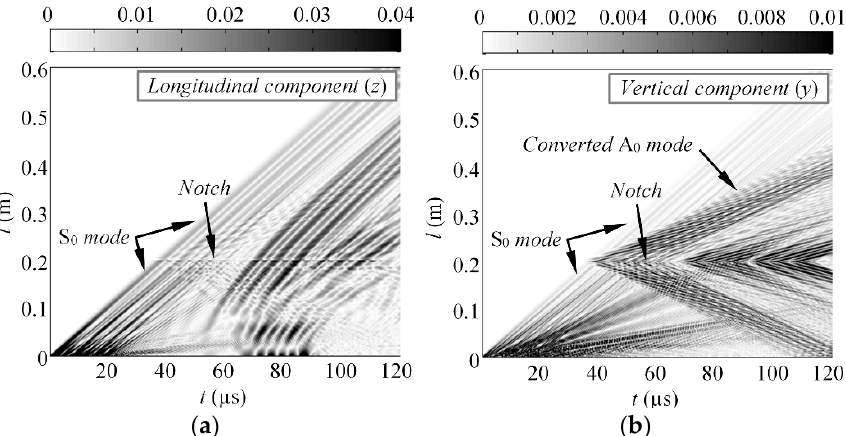
Figure 8. The ( a ) longitudinal and ( b ) vertical component of particle velocity along the centreline of the sample, in case of 150 kHz excitation.